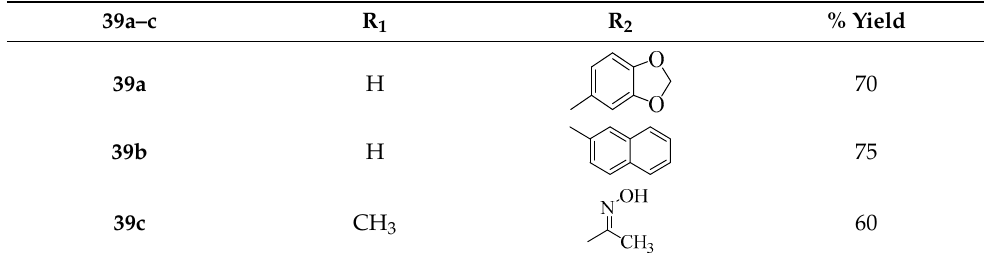
Table 1. Substitution pattern and percentage yields of quinazoline 3-oxides 39a – c .